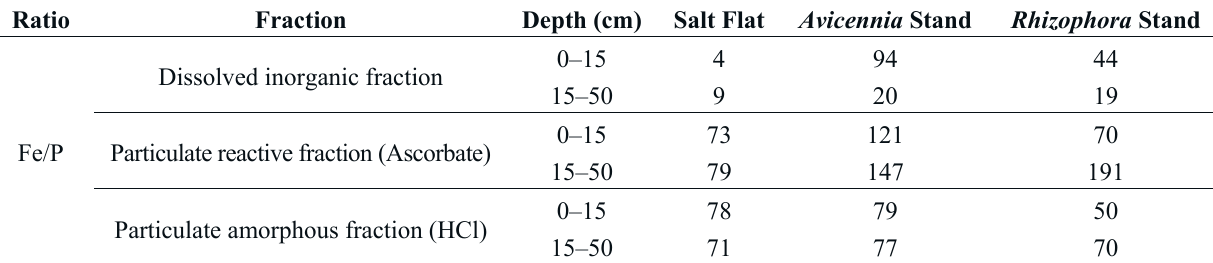
Table 2. Mean Fe/P ratios in upper sediments (0–15 cm) and underlying sediments (15–50 cm) of the three mangrove vegetation stands. This vertical limit at 15 cm was chosen as a function of TOC content and redox conditions. The upper layer reflecting a more active